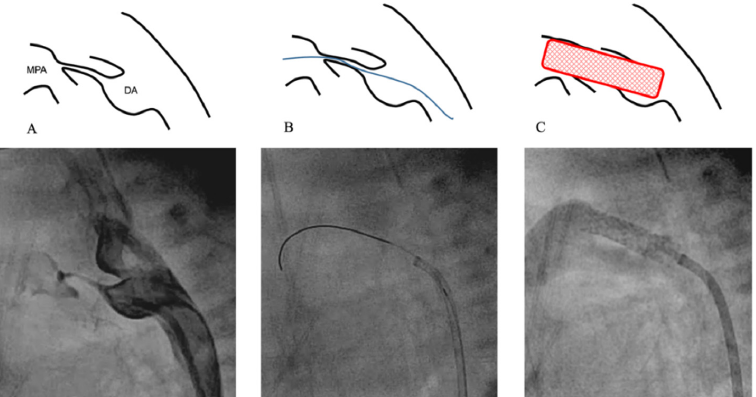
Figure 3. Lateral projection of the ductus arteriosus (DA) arising from proximal descending aorta and stenting procedure. ( A ) Selective ductal angiography demonstrated tightly constricted pulmo- nary artery end of the DA. ( B ) 0.014” coronary guidewire crossed the DA. ( C ) Stent covered entire length of the DA. MPA: Main pulmonary artery.